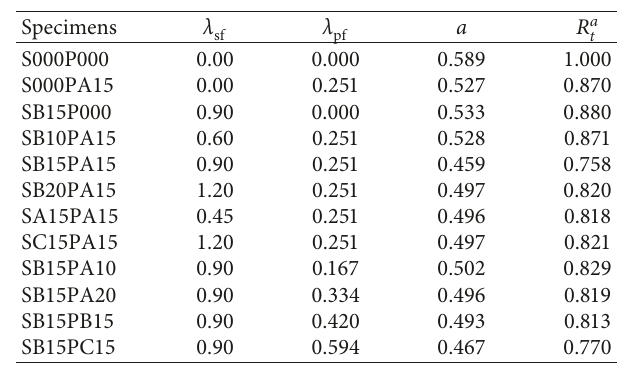
Table 4: Fitting parameters for the relation between plastic strain and envelope unloading strain.